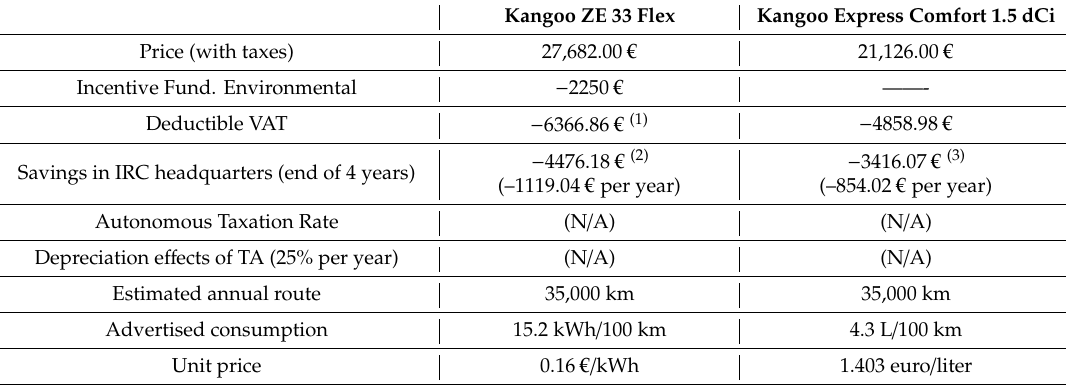
Table A2. 4-year exercise statement - Definitive acquisition (Comparison of light commercial